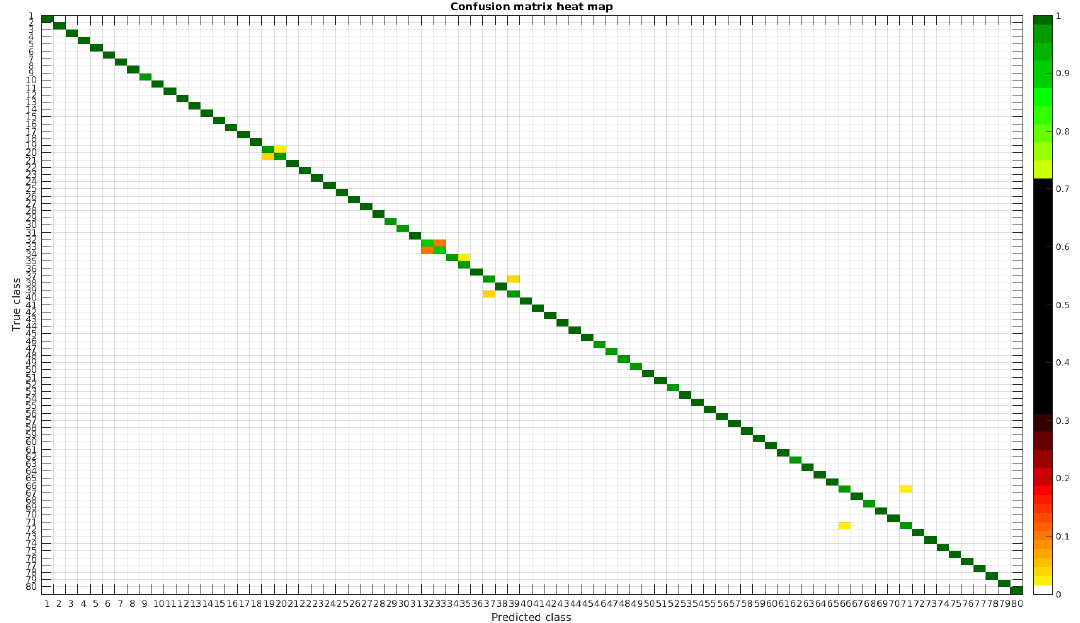
Figure 11. Confusion matrix heat map for the segmented dataset with 1000 samples per class.